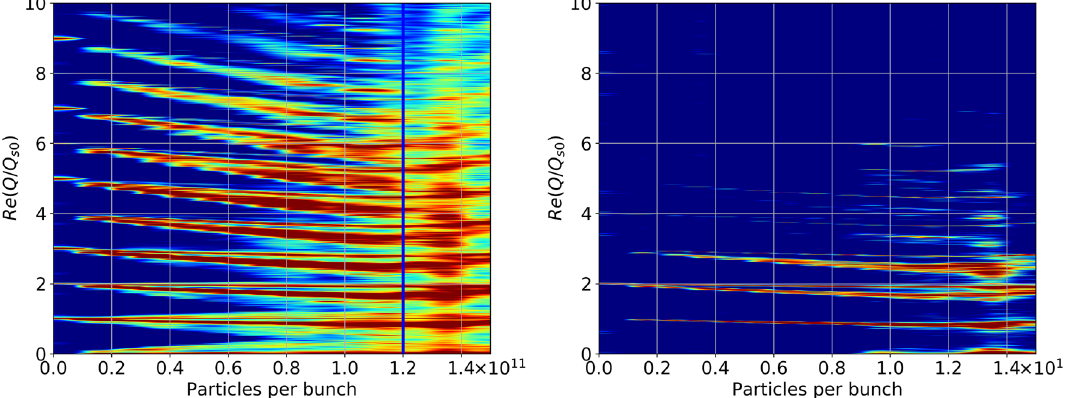
FIG. 8. Real part of normalized mode-frequency shift obtained with the results of SBSC with a BBR impedance. A Hanning window has been used for the Fourier transform. The left-hand side has been obtained by summing the first ten modes, the right-hand side has been obtained by using only the rms bunch length. The vertical blue line corresponds to the intensity threshold of the microwave